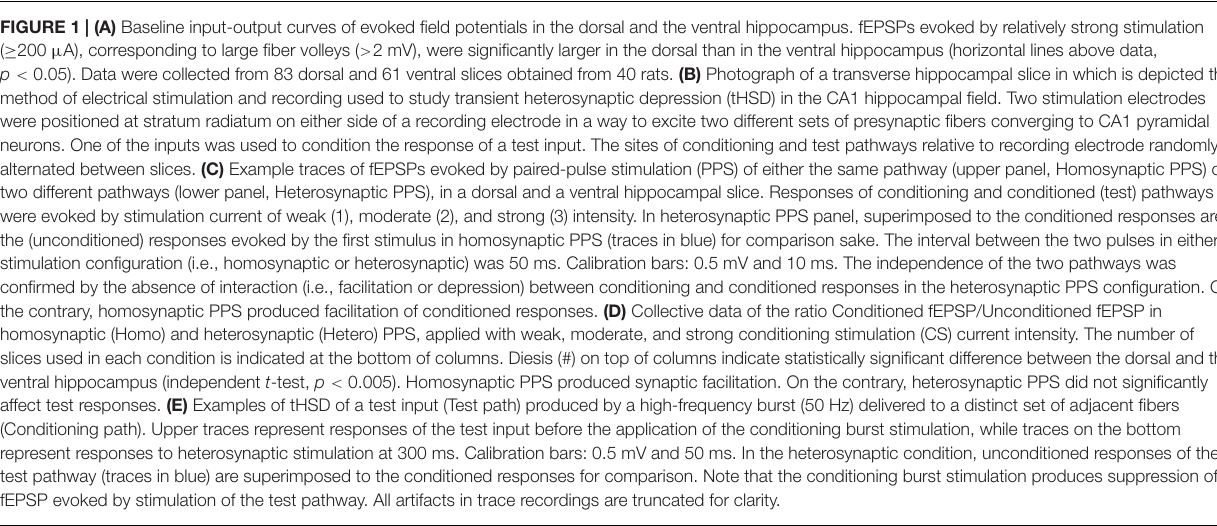
FIGURE 1 | (A) Baseline input-output curves of evoked field potentials in the dorsal and the ventral hippocampus. fEPSPs evoked by relatively strong stimulation ( ≥ 200 µ A), corresponding to large fiber volleys ( > 2 mV), were significantly larger in the dorsal than in the ventral hippocampus (horizontal lines above data, p < 0.05). Data were collected from 83 dorsal and 61 ventral slices obtained from 40 rats. (B) Photograph of a transverse hippocampal slice in which is depicted the method of electrical stimulation and recording used to study transient heterosynaptic depression (tHSD) in the CA1 hippocampal field. Two stimulation electrodes were positioned at stratum radiatum on either side of a recording electrode in a way to excite two different sets of presynaptic fibers converging to CA1 pyramidal neurons. One of the inputs was used to condition the response of a test input. The sites of conditioning and test pathways relative to recording electrode randomly alternated between slices. (C) Example traces of fEPSPs evoked by paired-pulse stimulation (PPS) of either the same pathway (upper panel, Homosynaptic PPS) or two different pathways (lower panel, Heterosynaptic PPS), in a dorsal and a ventral hippocampal slice. Responses of conditioning and conditioned (test) pathways were evoked by stimulation current of weak (1), moderate (2), and strong (3) intensity. In heterosynaptic PPS panel, superimposed to the conditioned responses are the (unconditioned) responses evoked by the first stimulus in homosynaptic PPS (traces in blue) for comparison sake. The interval between the two pulses in either stimulation configuration (i.e., homosynaptic or heterosynaptic) was 50 ms. Calibration bars: 0.5 mV and 10 ms. The independence of the two pathways was confirmed by the absence of interaction (i.e., facilitation or depression) between conditioning and conditioned responses in the heterosynaptic PPS configuration.